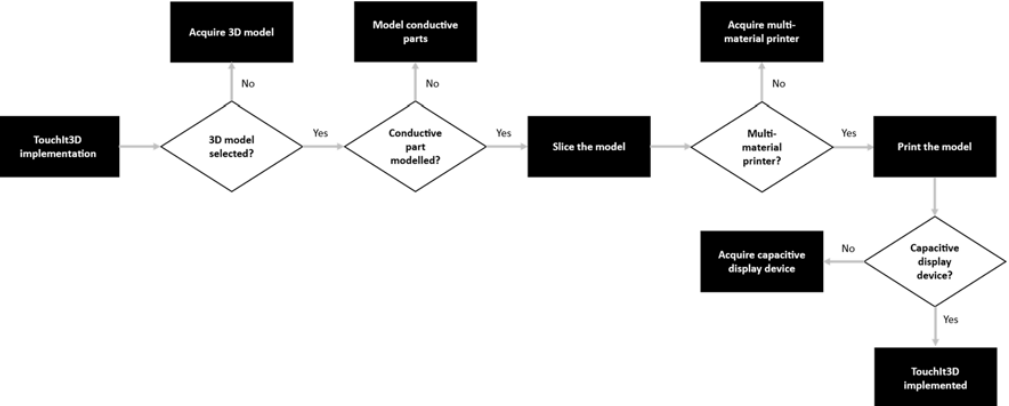
Figure 2. TouchIt3D implementation steps. Notably, a 3D printer with multi ‐ material capabilities